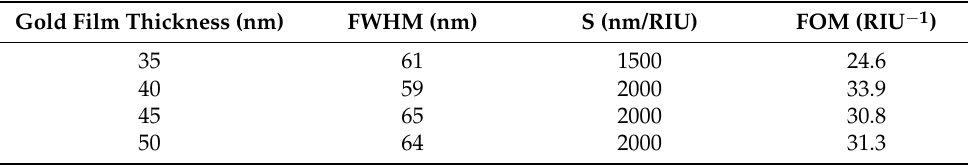
Figure 5. ( a ) Loss spectrum curve. ( b ) Amplitude sensitivity with different gold layer thicknesses from 35 to 50 nm. Table 2. Quality factors corresponding to different gold layer